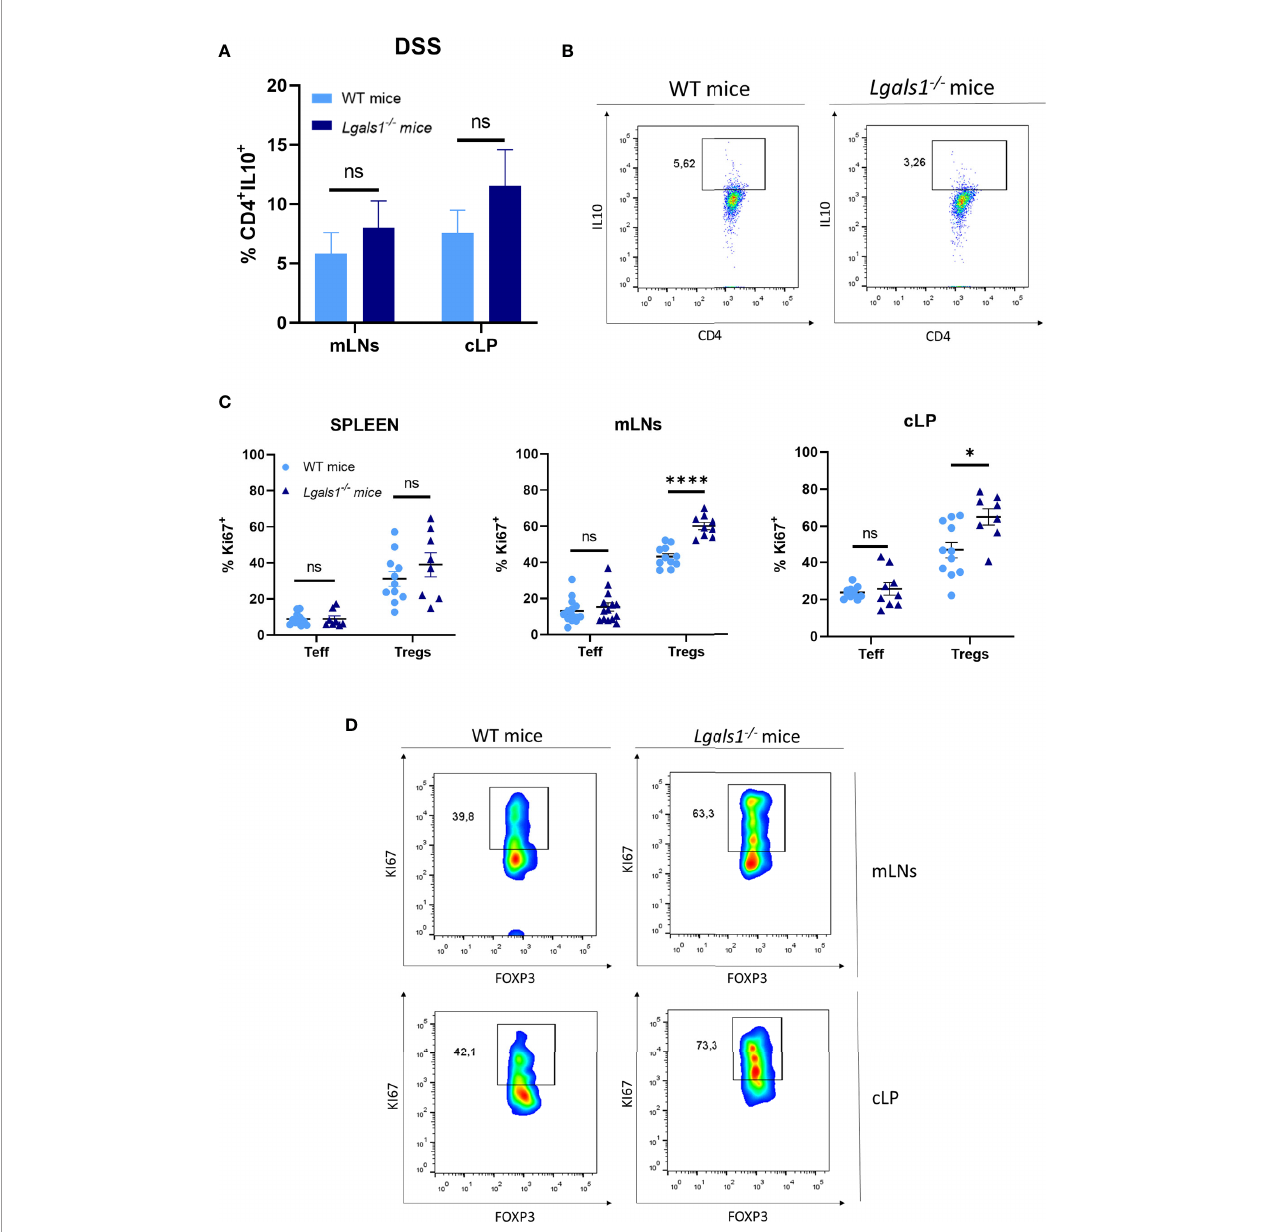
FIGURE 4 | Increased proliferation rate ofFOXP3 + CD4 + regulatory T cells inmLNs and cLPof DSS-colitic Lgals1 − / − mice comparedto colitic WTmice. (A) IL-10 + CD4 + frequencies in mLNs and cLP(n= 7 for WTand, n = 8 for Lgals1 − / − mice per group).Dataare representative of two independent experiments. (B) Representative examples of CD4 + IL-10 + dot plot FACS analysis of cLPincolitic mice. (C) Proliferation rate measured bythe expression of Ki67 + inT effector cells and FOXP3 + Tregs cells incolitic mice (n = 14 for WTand, n = 14 for Lgals1 − / − mice per group).Data are representative ofthreeindependent experiments. (D) Representative examples of Ki67 + FOXP3 + within CD4 + T cells dot plots FACS analysis of mLNs and cLPincoliticmice. Numbersrepresent analyzed population percentages in therespective gates. Statistical analysis was done usingMann – Whitney test. Data are shown as mean ± SEM, ns , not signi fi cant ; *p < 0.05 and ****p <